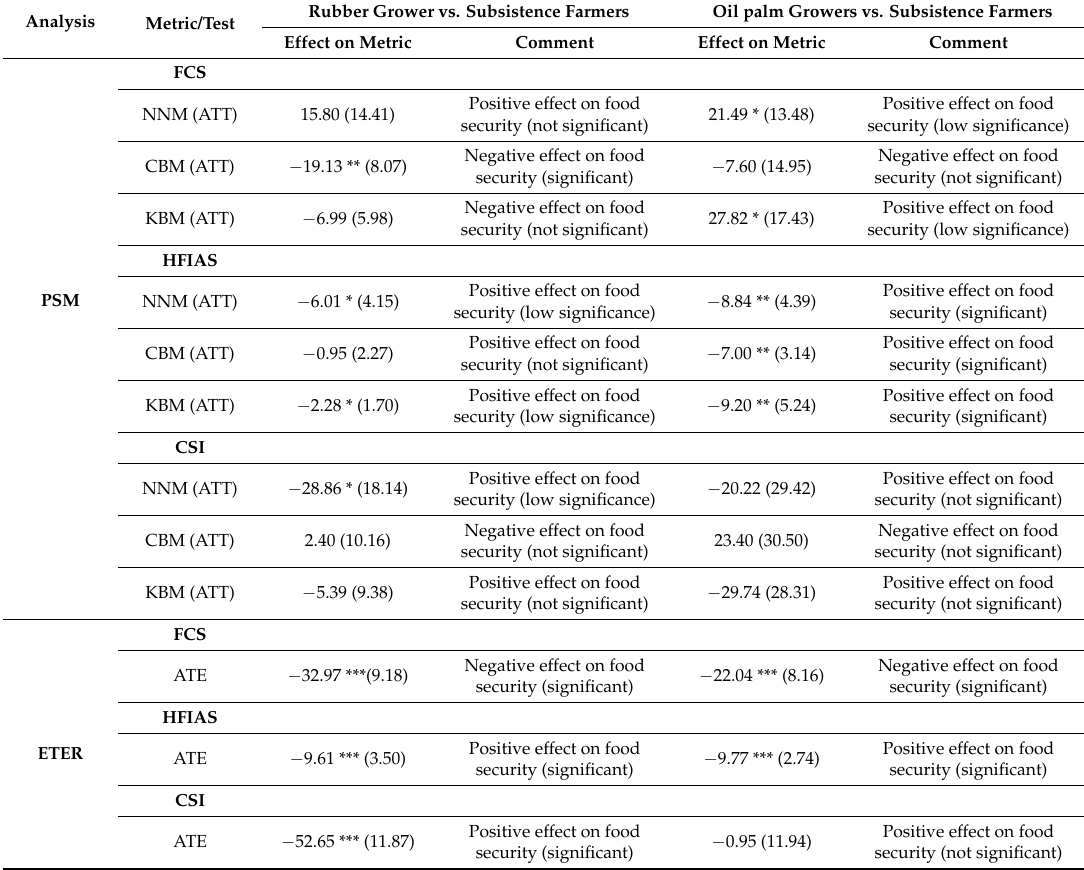
Table 7. Food security outcomes of involvement in industrial crop cultivation for all metrics and tests.